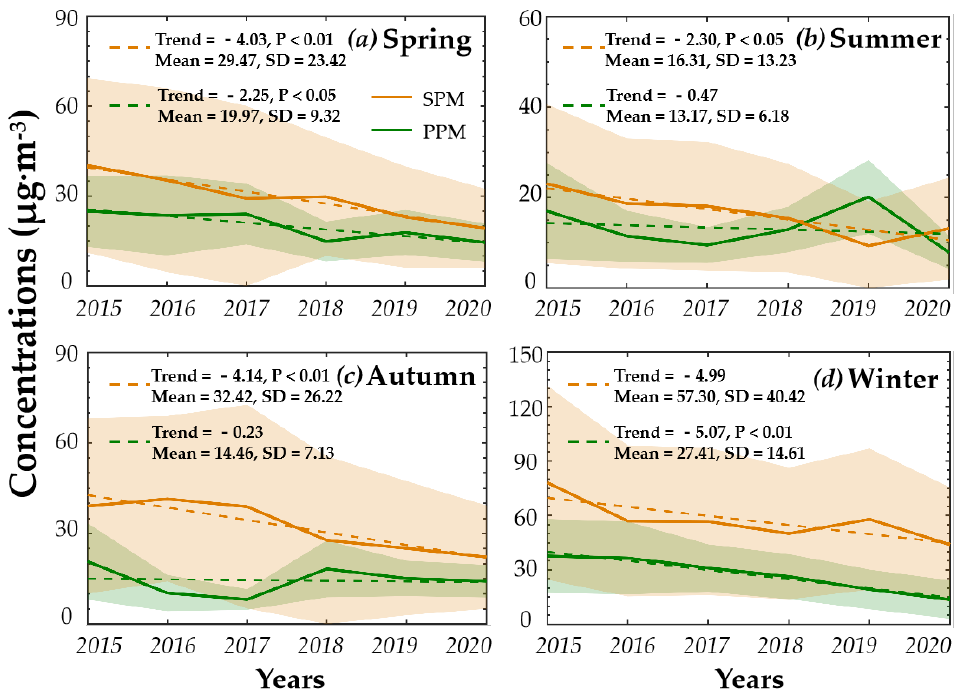
Figure 5. Same as Figure 4 but for ( a ) spring, ( b ) summer, ( c ) autumn, and ( d ) winter.